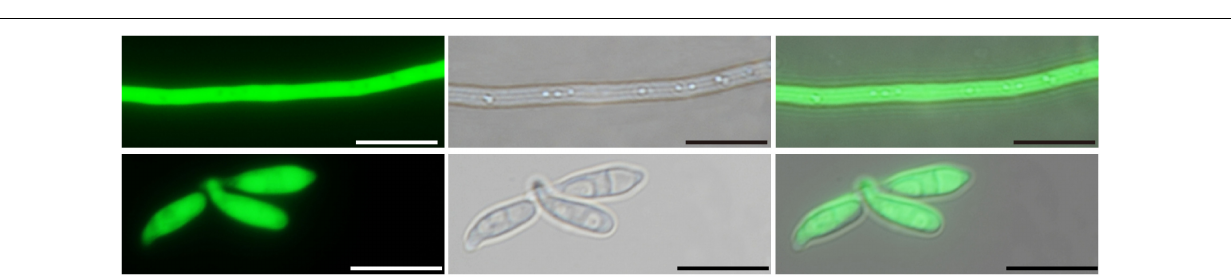
FIGURE 3 | Laser scanning confocal microscopy of the GFP-expressed P. oryzae transformant. Hyphae and conidia showed constitutive GFP expression. Bar, 10 µ